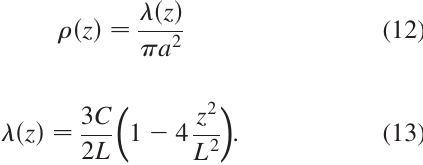
FIG. 14. Square root of (cid:1) (cid:1) 2 as a function of initial current with z nonzero initial emittance; effect of bend shows up in low current regime. Otherwise, longitudinal emittance growth is dominated by space